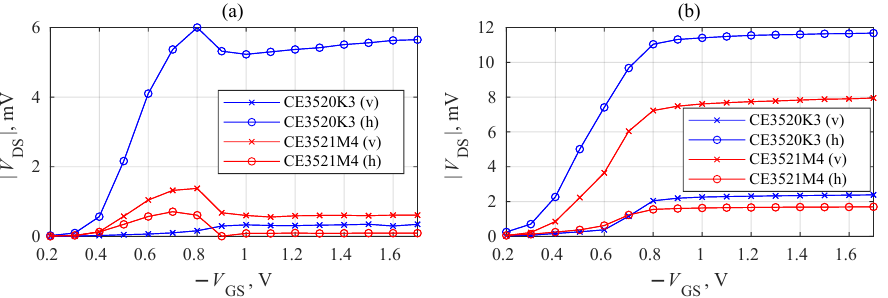
Figure 3. Dependence of detected drain–source voltage V DS on the gate–source voltage V GS under the 0.094 THz focused beam. The subplot labels ( a , b ) also correspond to the PCB configurations in Figure